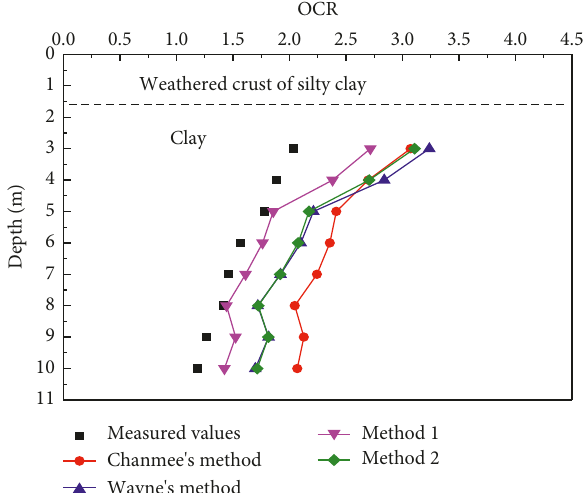
Figure 9: Comparison of the measured values and predicted values of the OCR using Chanmee’s